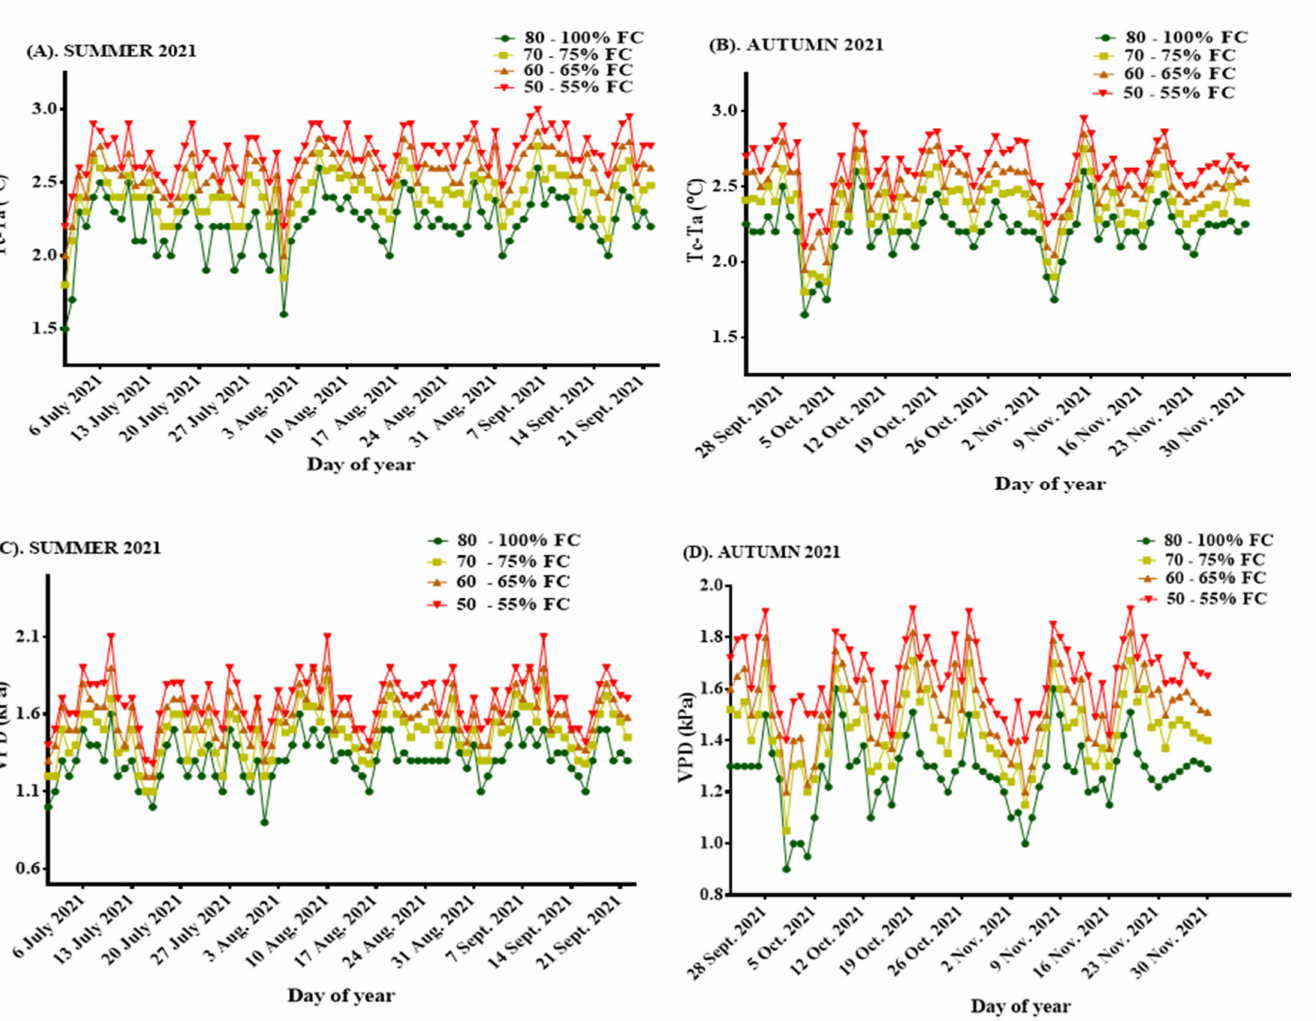
Figure 5. ( A ) Weekly T c − T a ( ◦ C) for summer, 2021; ( B ) Weekly T c − T a ( ◦ C) for summer, 2021; ( C ) Weekly VPD (kPa) for autumn, 2021; ( D ) Weekly VPD (kPa) for autumn,